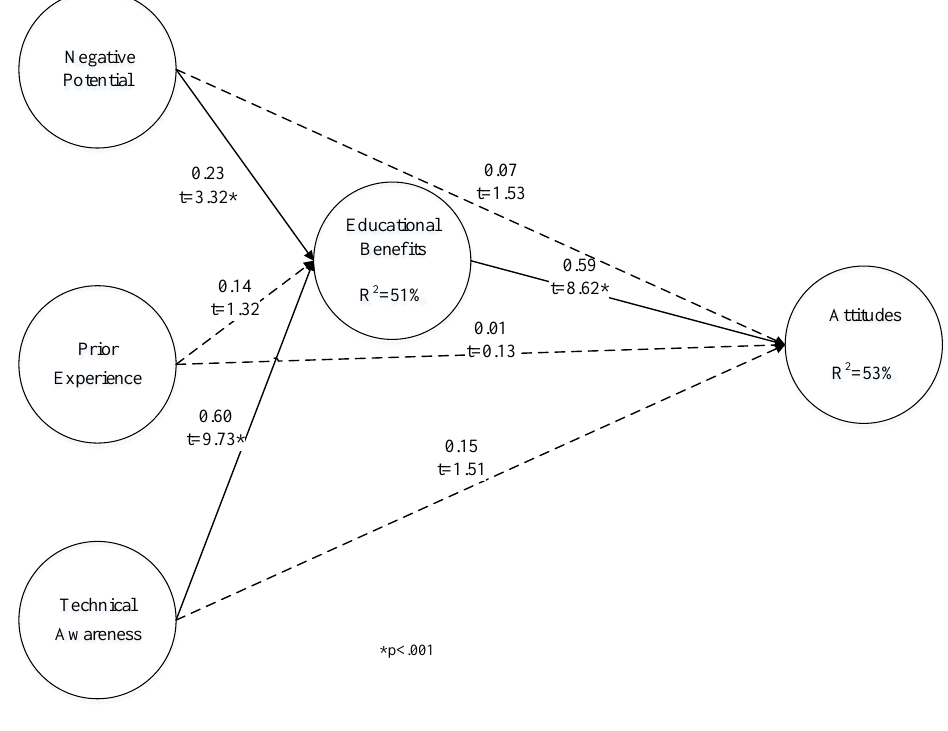
Figure 5. Results of structural model test for